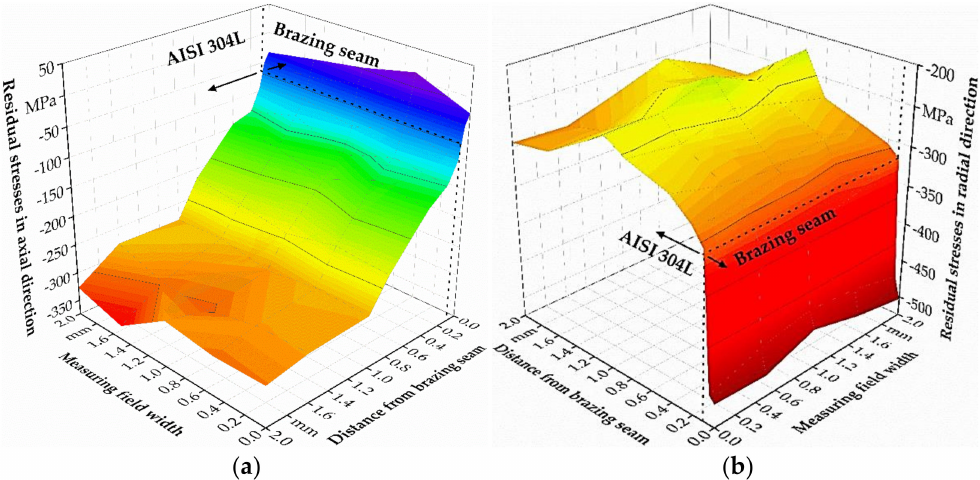
Figure 11. Distribution of residual stresses of ST20 40min in the ( a ) axial direction and ( b ) radial direction—measuring points according to Figure